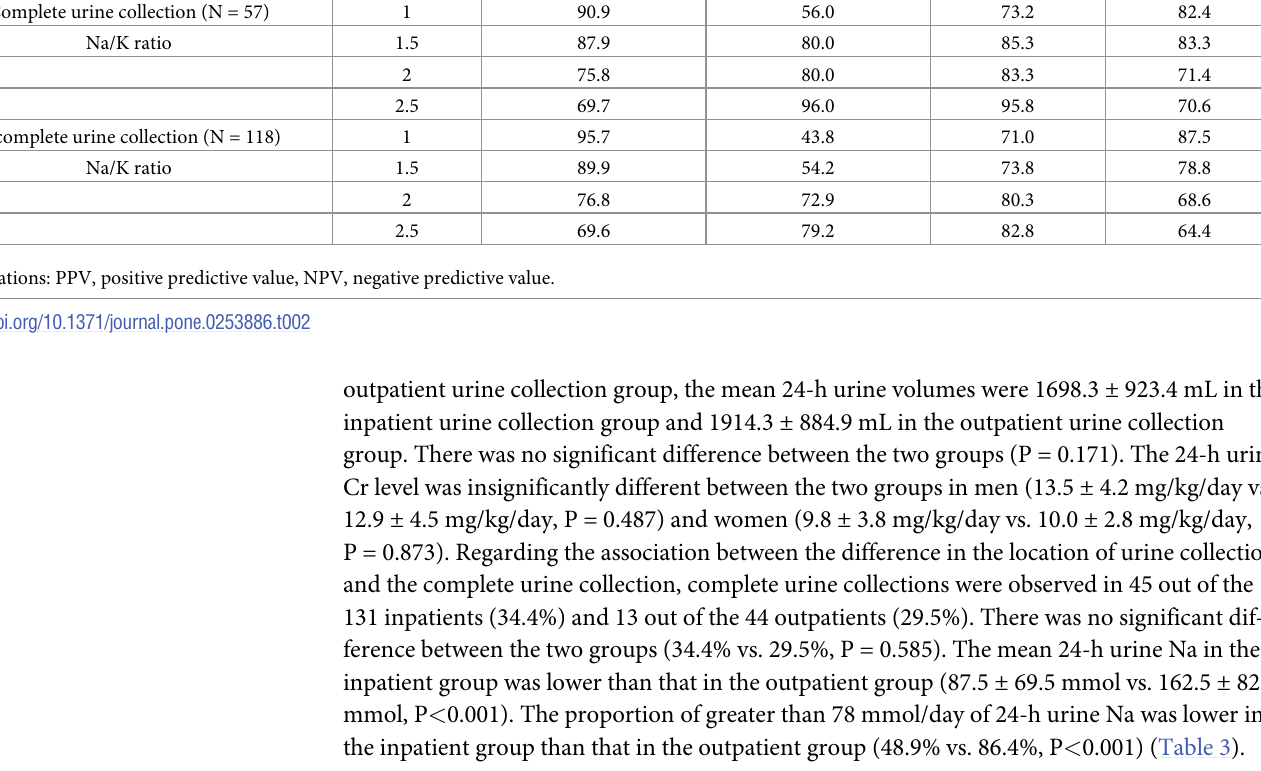
Table 3. 24-h urine test result and complete urine collection between the inpatient and outpatient groups.